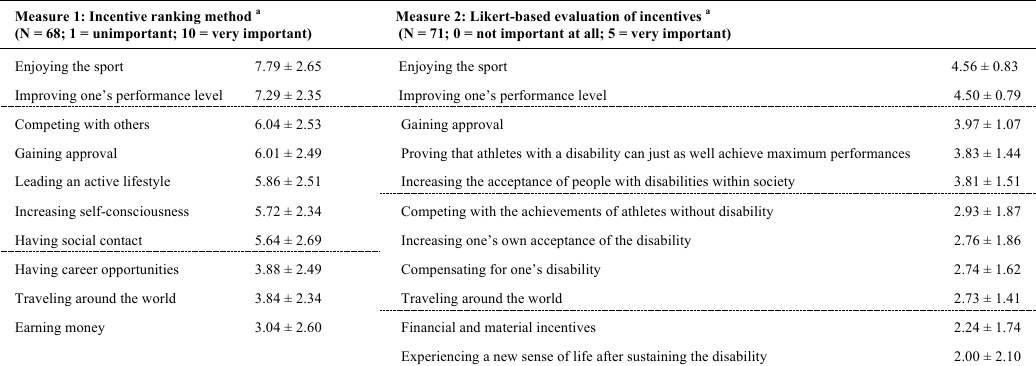
Note. The dotted lines indicate the grouping of the variables mentioned in the